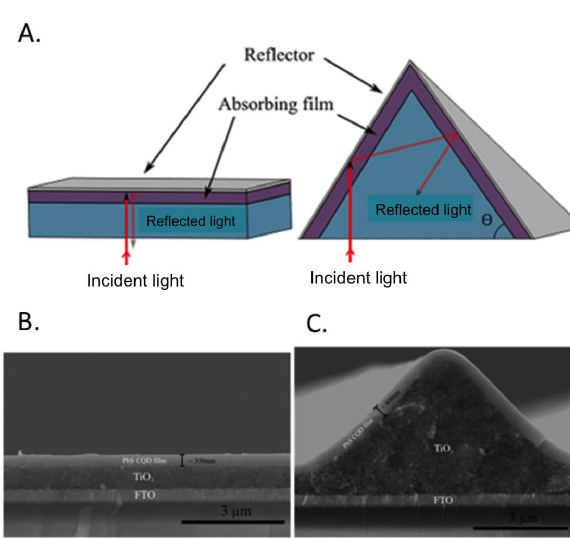
Fig. 5. (A) Schematics of planar (left) a pyramid-patterned (right) thin-film solar cells, illustrating the increased light-path-length advantage of pyramid-patterned electrodes. (B) Cross-sectional scanning electron microscope image of a planar CQD device. The film thickness is ∼ 350 ±30 nm. (C) Cross-sectional scanning elec- tron microscope image of a pyramid-patterned CQD device. The film thickness is ∼ 400 ±30 nm. Reprinted with permission from